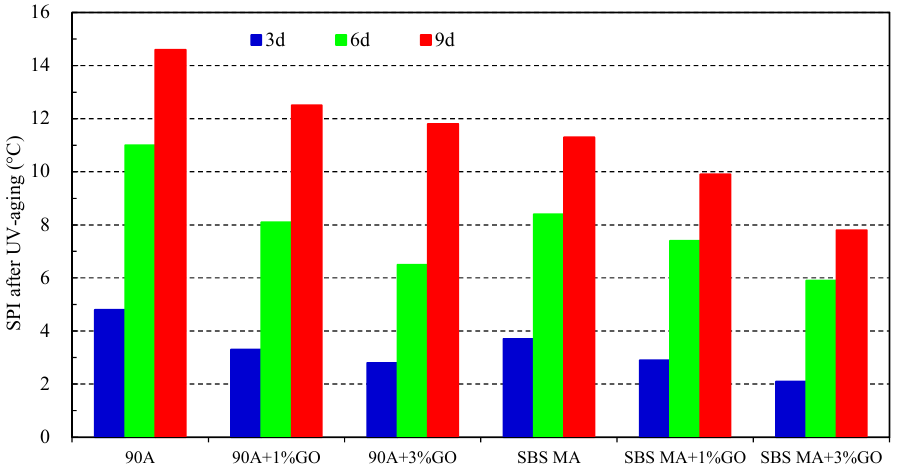
Figure 5. The SPI of asphalt after UV aging.